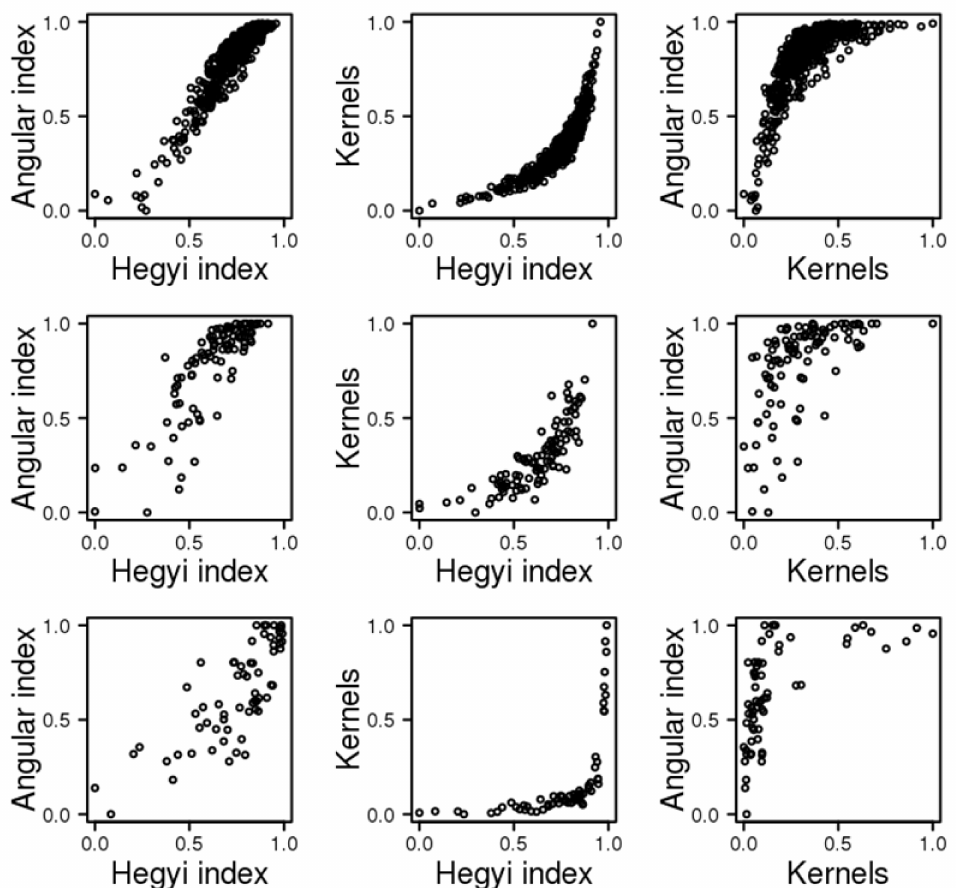
Figure 3. The normalized values of different competition indices for some sample stands, plotted against each other. The upper row represents the young pine stand with random placement of trees, the middle row represents the pole stand with equal portions of birch and aspen with a clustered placement, and the bottom row represents the mature pine stand with spruce undergrowth under the